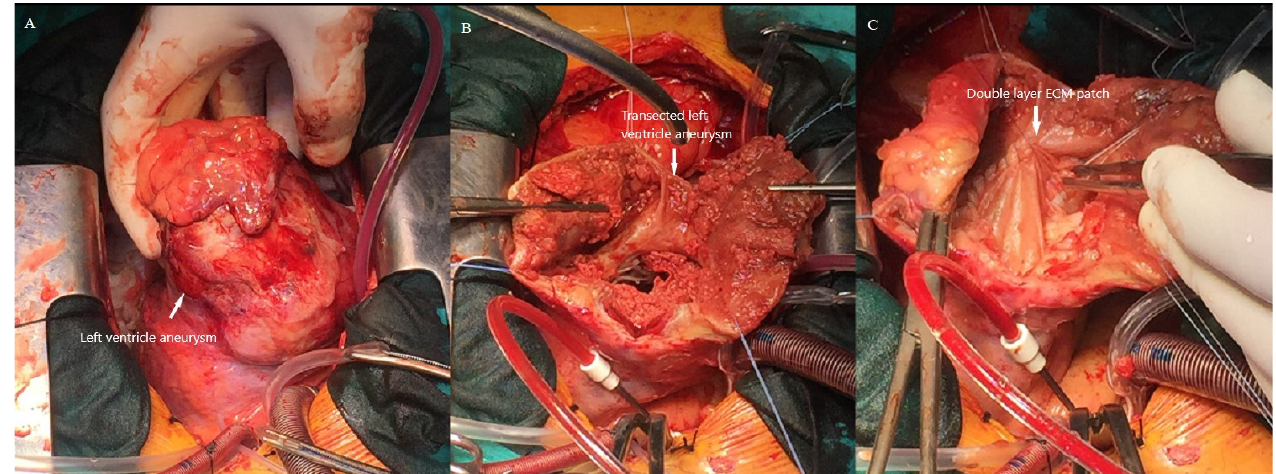
Fig. 2 - Surgical reconstruction of the left ventricular aneurysm. (A) Surgical view of the giant left ventricular aneurysm. (B) The aneurysmal cavity transected after thrombus debridement and detection of the junction between scar and viable myocardium. (C) Double-layer extracellular matrix sutured on the aneurysmal rim using polypropylene over and over the suture. ECM=extracellular matrix.